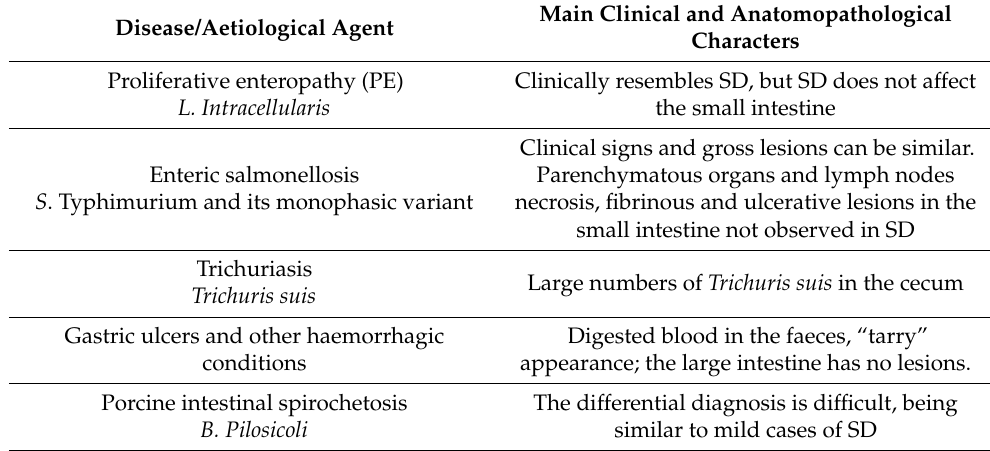
Table 2. SD and differential diagnosis